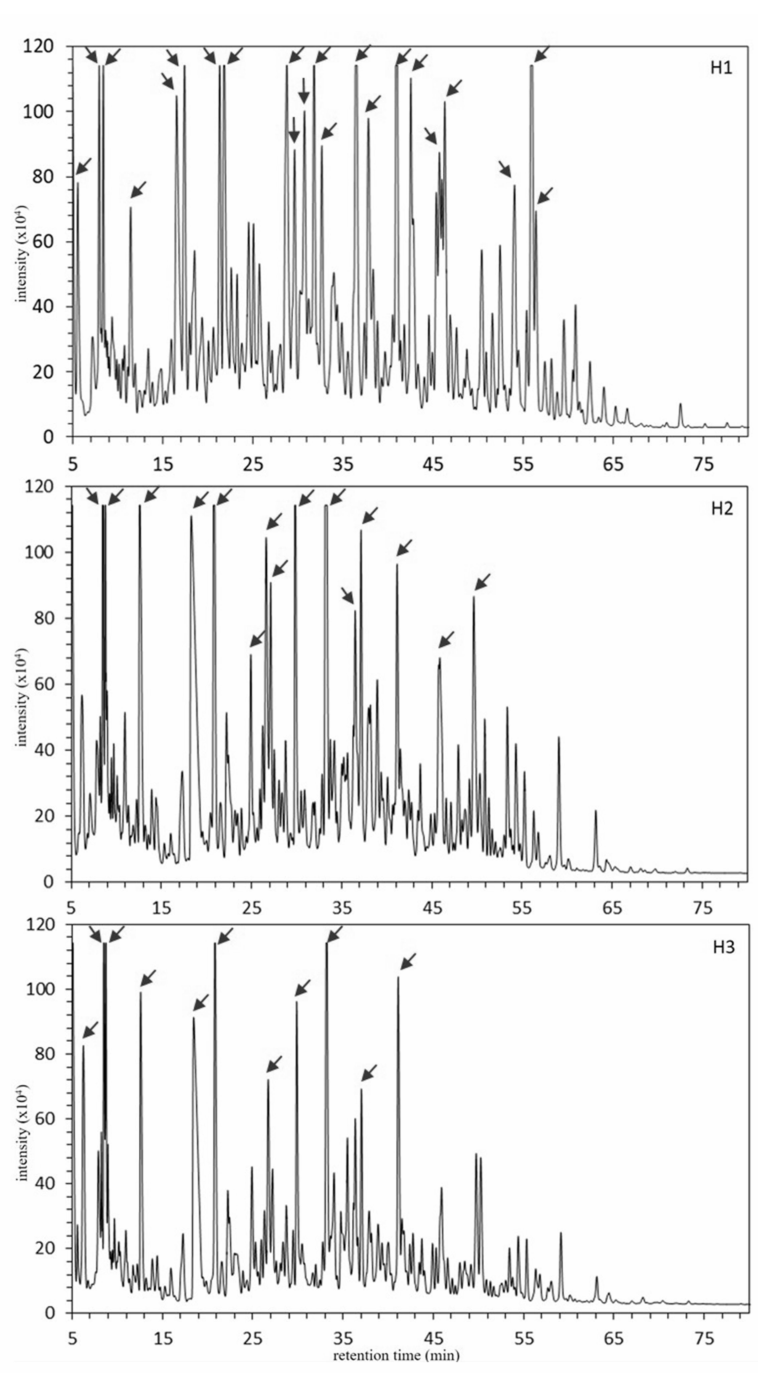
Figure 2. The RP-HPLC chromatograms of ultrafiltrates (NMWL 3000) of three fermented mare’s milks obtained from di ff erent herders. Arrows indicate fractions manually collected for MS / MS peptide identification. The peak IDs were given in accordance with their retention time, e.g., the arrow indicating the left-most peak’s ID in H1 is